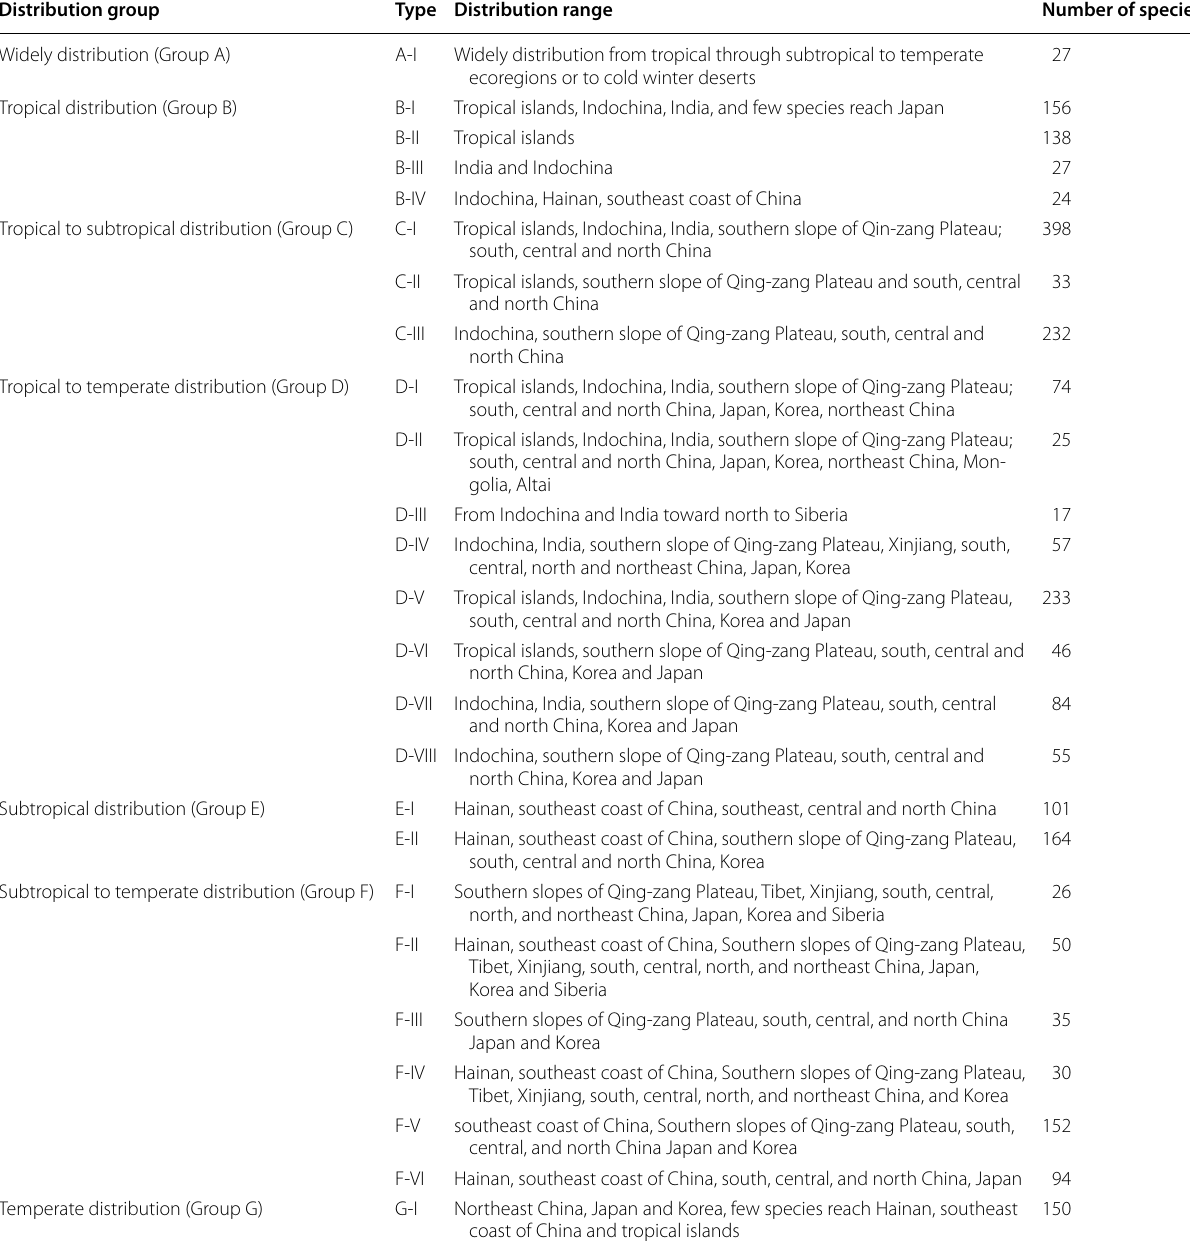
The NEASTs were categorized into 7 distribution groups and 25 types according to their distribution ranges in Asia. Descriptions of geographical distribution ranges and numbers of angiosperm species of each type were listed in the